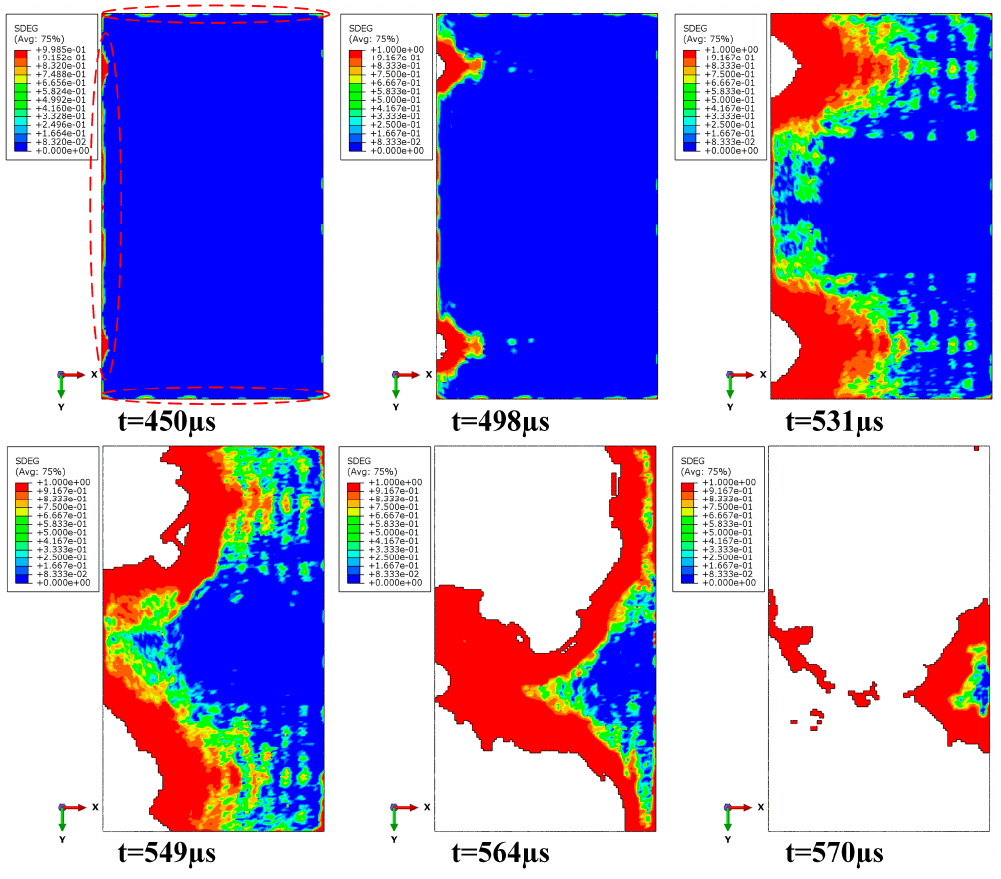
Figure 17. Cohesive layer damage evolution process.